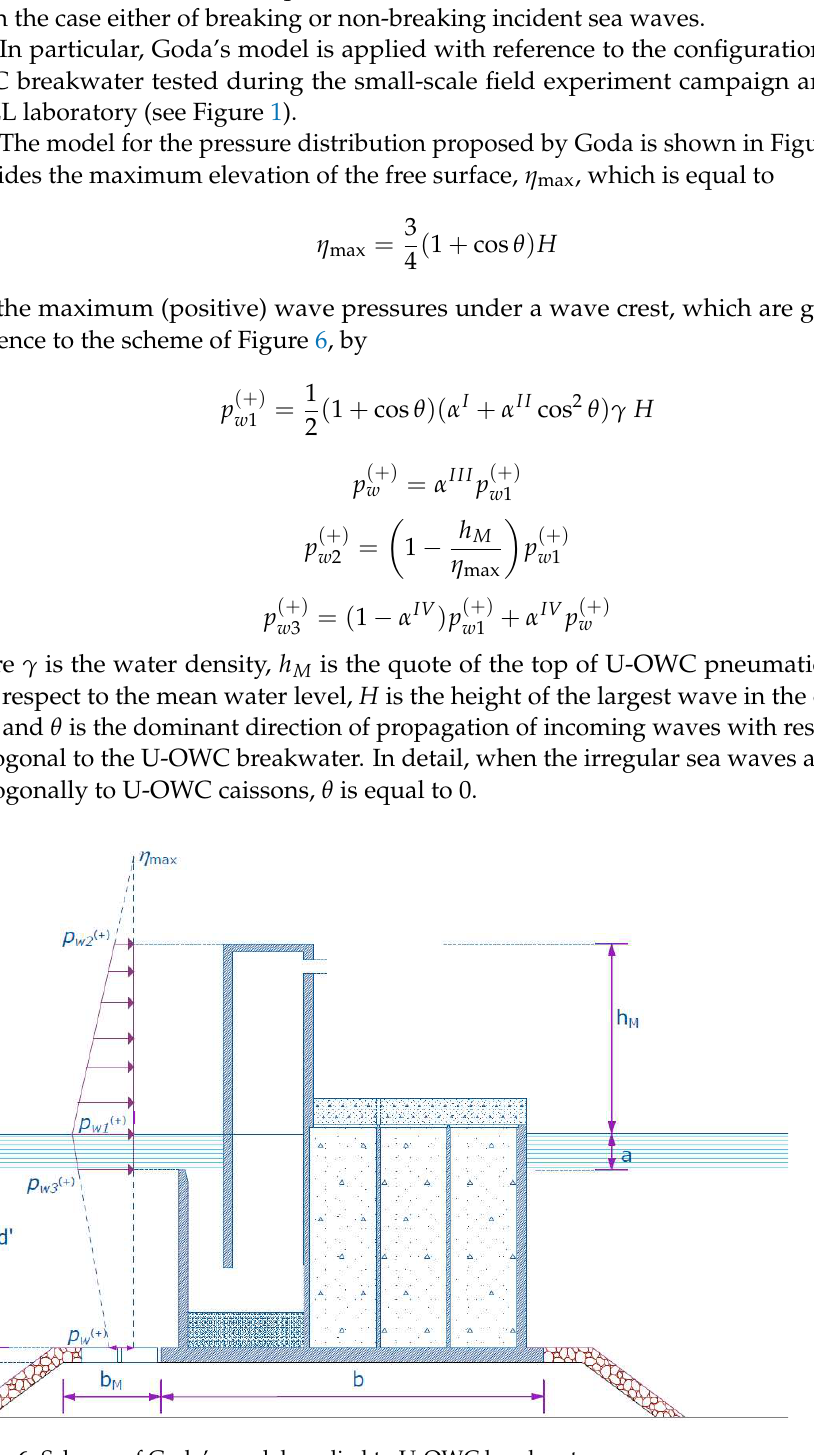
Figure 6. Scheme of Goda’s model applied to U-OWC breakwater.